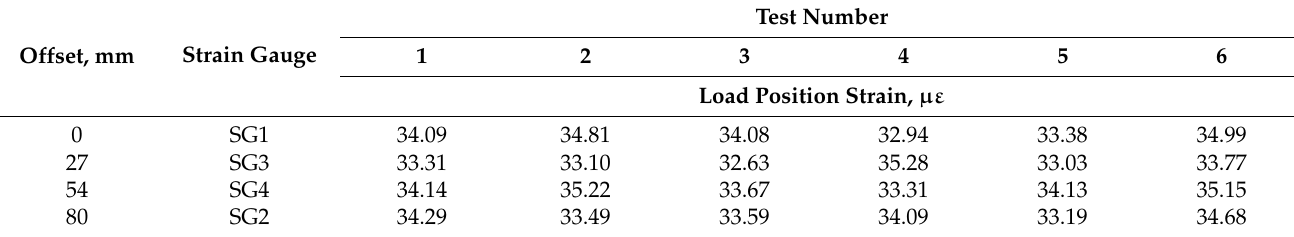
Table 2. Dynamic strains with manually recorded offsets for load position strain verification.